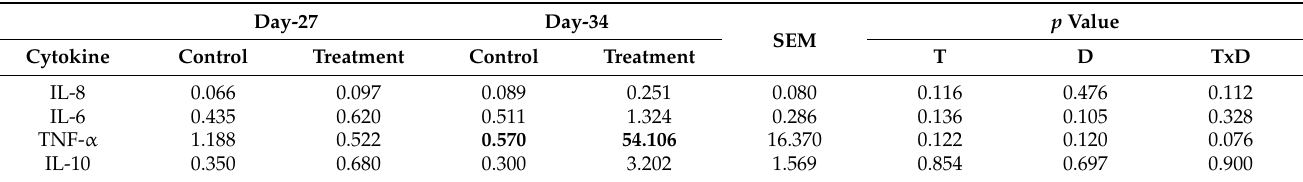
Table 4. Cytokine determination (ng/mL) in serum samples from in vivo swine treatments with IL-1 β nanoparticles and in the control treatment. The mean of each treatment and SEM are indicated. Highlighted results indicate a tendency. T: treatment; D: